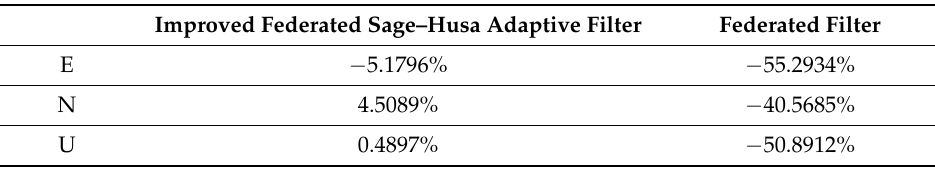
Table 9. The precision changes of the two filters in E-N-U